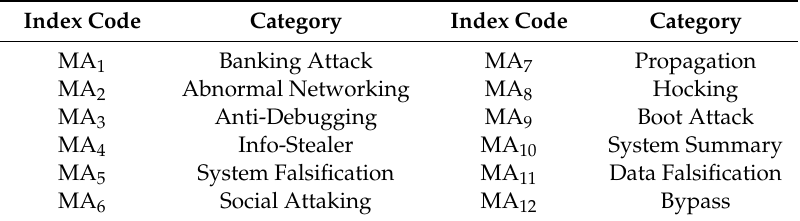
Table 2. Malicious activities